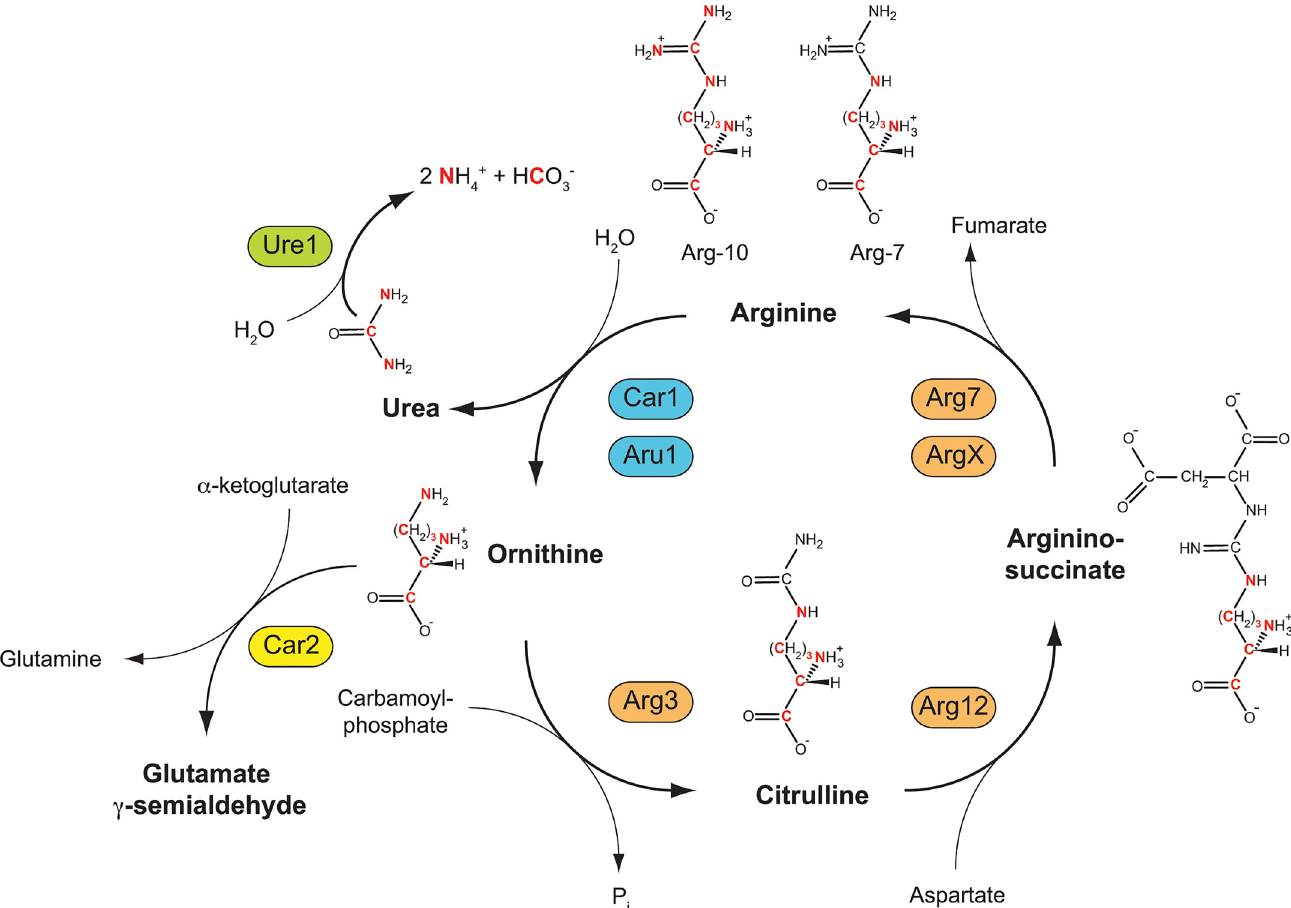
Fig 3. Anabolic and catabolic reactions from 13 C 615 N 4 -arginine (Arg-10) leading to formation of “ heavy ” ammonium and “ heavy ” bicarbonate, and resynthesis of 13 C 515 N 2 -arginine (Arg-7). Two S. pombe arginases, Car1 and Aru1, catalyze the conversion of Arg-10 into 13 C 515 N 2 -ornithine ( “ heavy ” ornithine; “ heavy ” atoms are shown in red). This also produces “ heavy ” urea, which can be hydrolyzed by urease Ure1 to produce “ heavy ” ammonia and “ heavy ” carbon dioxide (shown here as ammonium and bicarbonate ions, respectively), which can subsequently be incorporated into additional amino acids. Ornithine can be converted back into arginine through citrulline and arginino-succinate intermediates, ultimately leading to formation of